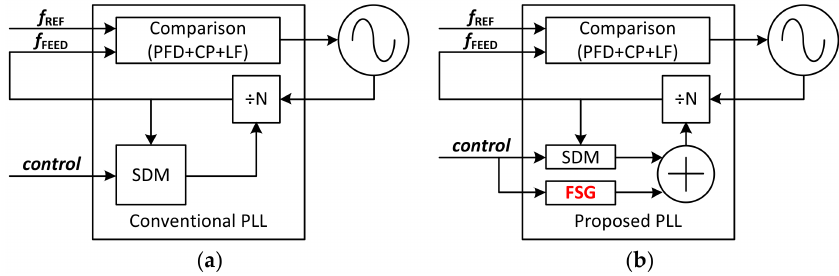
Figure 5. Comparison of dual-mode LO ( a ) the conventional and ( b ) the proposed structure using division ratio control